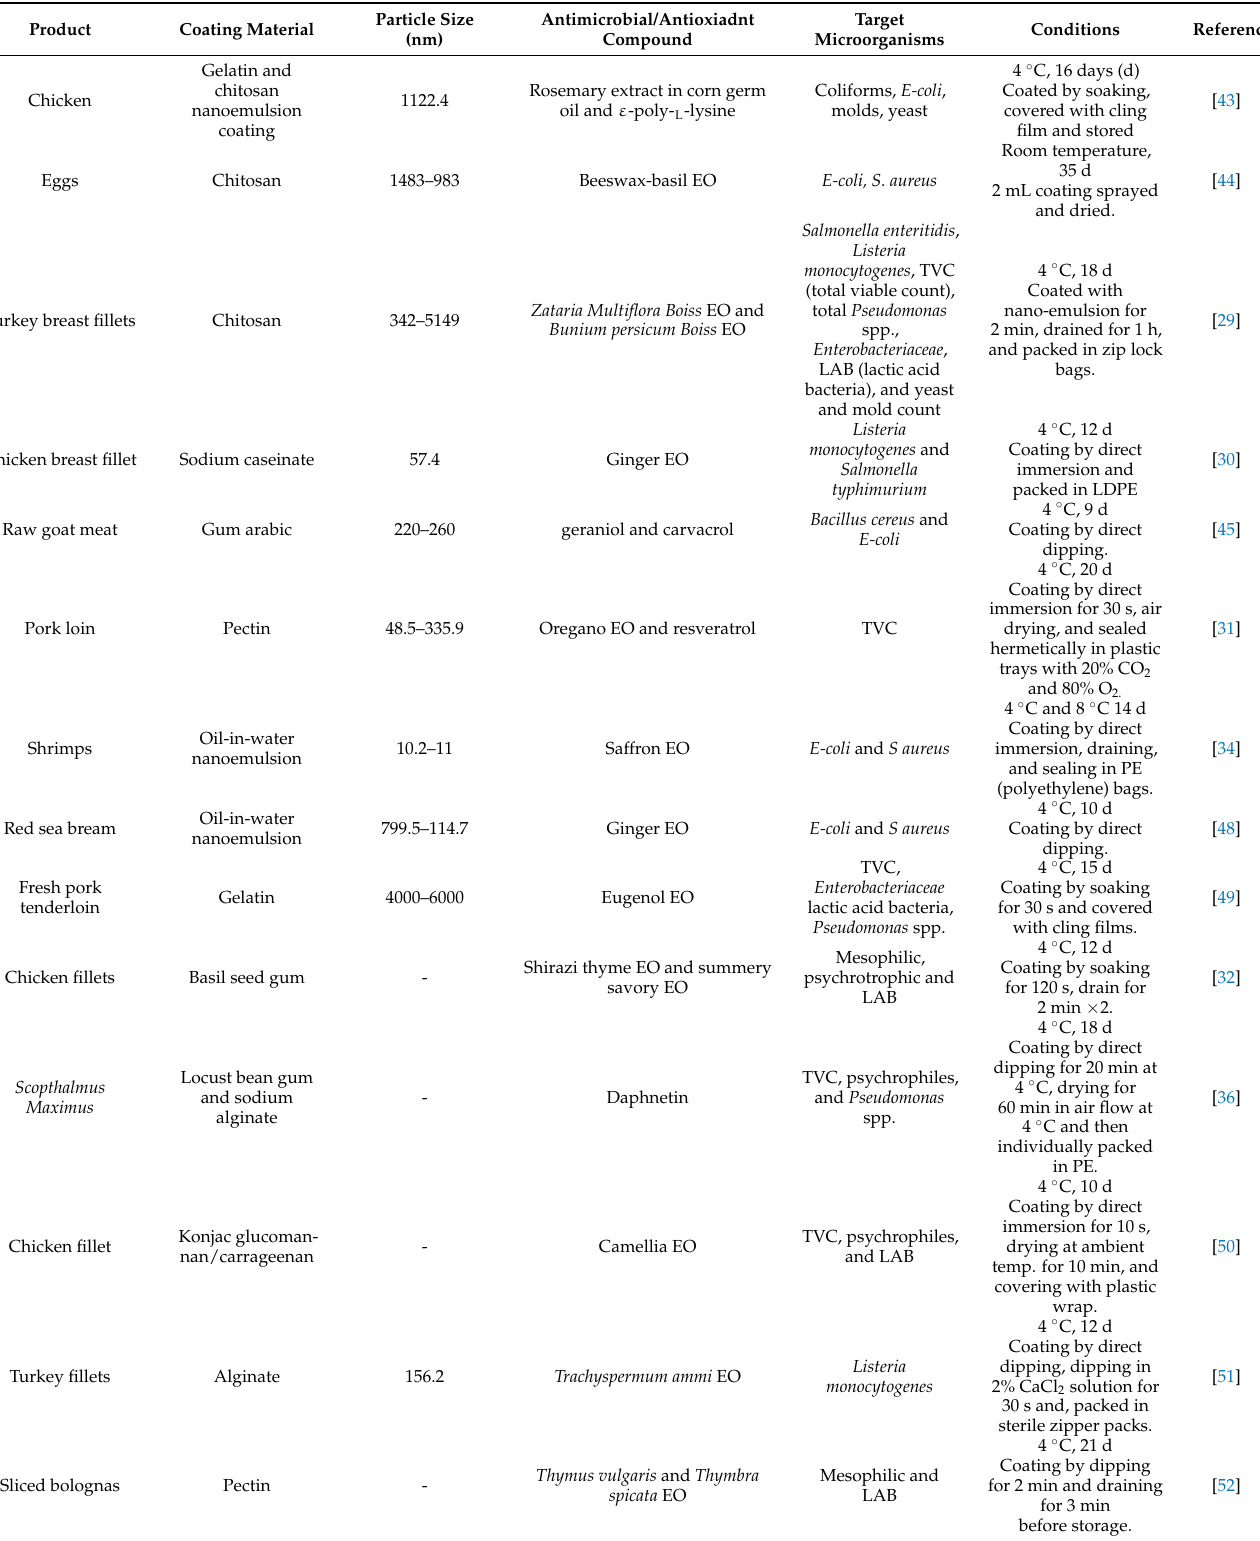
Table 2. Summary of the composition, particle size, antimicrobial/antioxidant compound, target microorganisms, production, and shelf life conditions studied in the